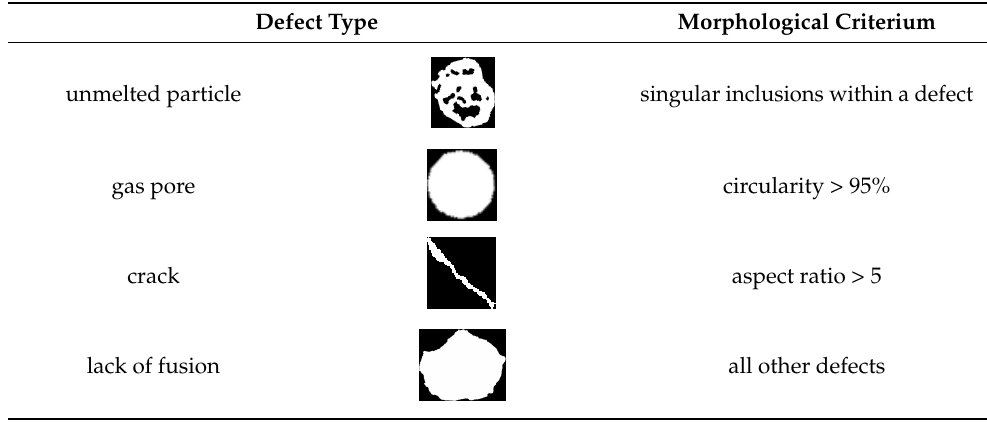
Table 3. Currently implemented defect types.